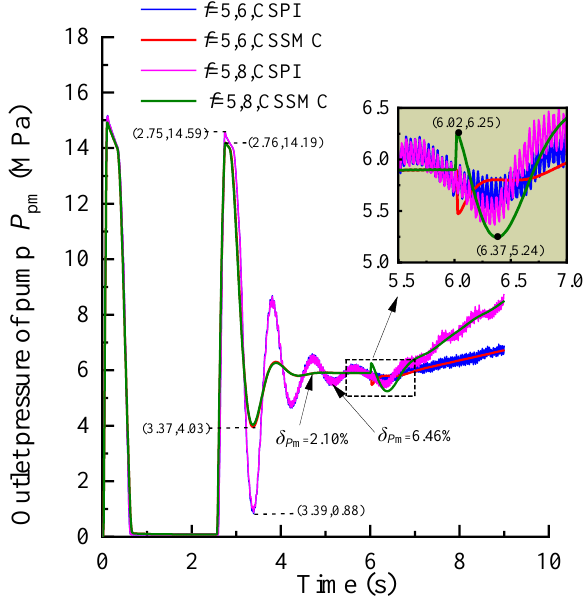
Figure 6. Variation curve of the hydraulic pump outlet pressure based on the CSPI and CSSMC.